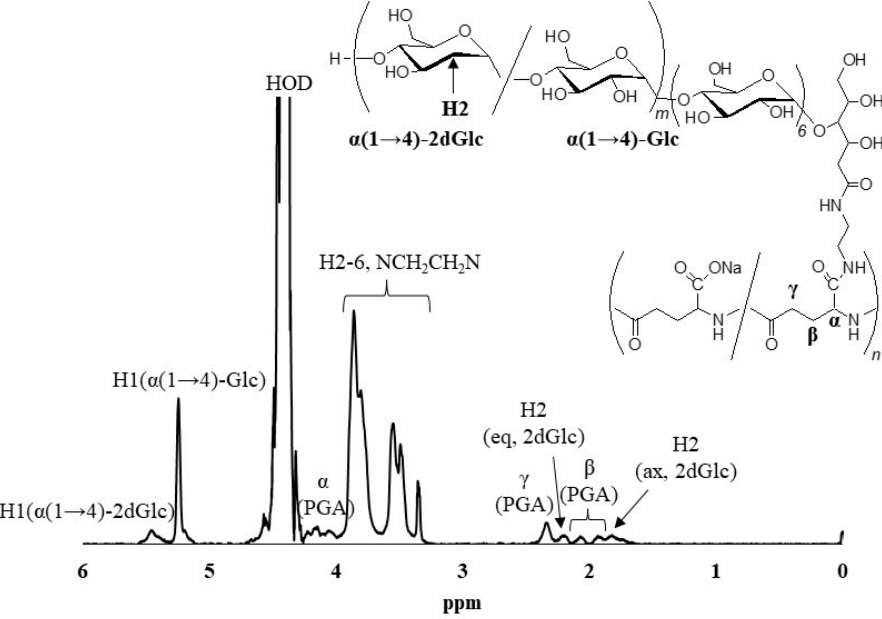
Figure 3. 1 H NMR spectrum of P2D-amylose-grafted PGA (entry 2, Table 1) in NaOD/D 2 O.